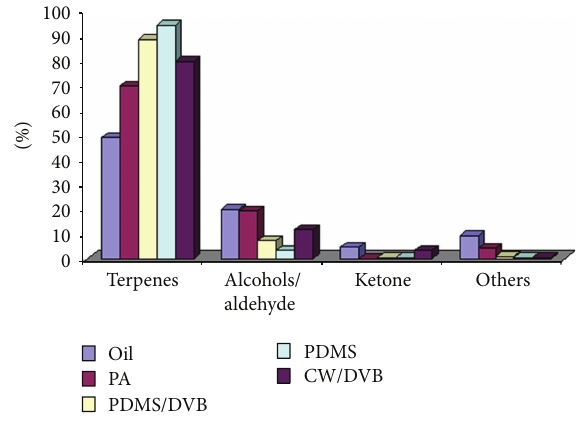
Figure 2: Percentage composition of the major chemical classes detected in the oil and by using different SPME